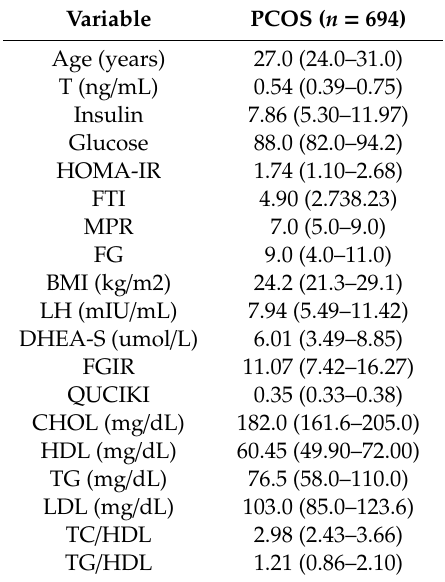
Table 1. Characteristics of the whole studied